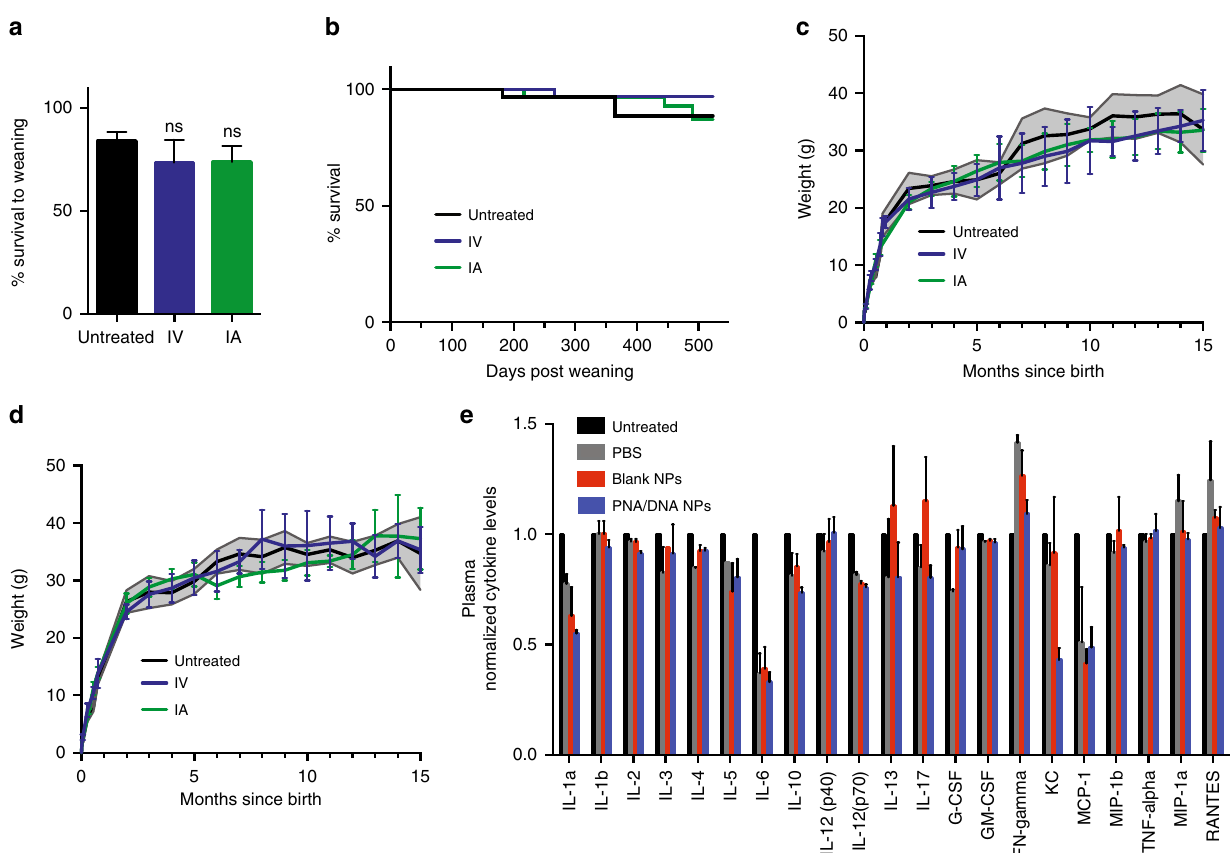
Fig. 2 Safety of in utero nanoparticle (NP) delivery. a Survival to weaning (21 days) of mice injected intravenously (IV) or intra-amniotically (IA) with γ tcPNA/DNA NP compared to mice subjected to sham surgery (untreated controls) (untreated n = 7 litters, IV n = 4 litters, IA n = 7 litters), the data are mean ± s.e.m., statistical analysis by one-way ANOVA, p = 0.5053. b Long-term survival of IV and IA NP injected mice compared to untreated controls ( n = 15 females and n = 15 males for each group), statistical analysis by Log-rank Mantel-Cox test, p = 0.8490. c , d Weight of IV and IA NP injected ( c ) female and ( d ) male mice compared to untreated controls, ( n = 10 for each group), gray-shaded region indicates the standard deviation of the control group. The data are shown as mean ± s.d., statistical analysis by two-way ANOVA. e Analysis of cytokine levels in plasma of E15.5 fetuses treated IV with PBS, blank NPs, or γ tcPNA/DNA NP compared to untreated fetuses 48 h post treatment ( n = 3 for each group), the data are mean ± s.e.m., statistical analysis by two-way